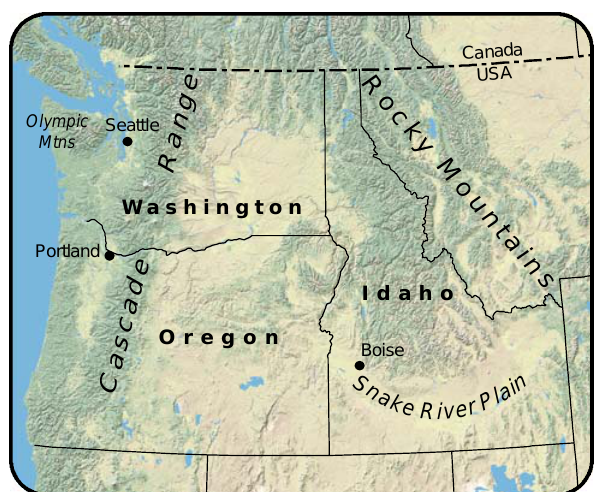
Fig. 1. Map of the study region, defined as the region encompassed by the US states of Idaho, Oregon, and Washington. The map and legend highlight several geographic features as well as the cities of Boise, Portland, and Seattle. The color scale shows elevation above sea level in